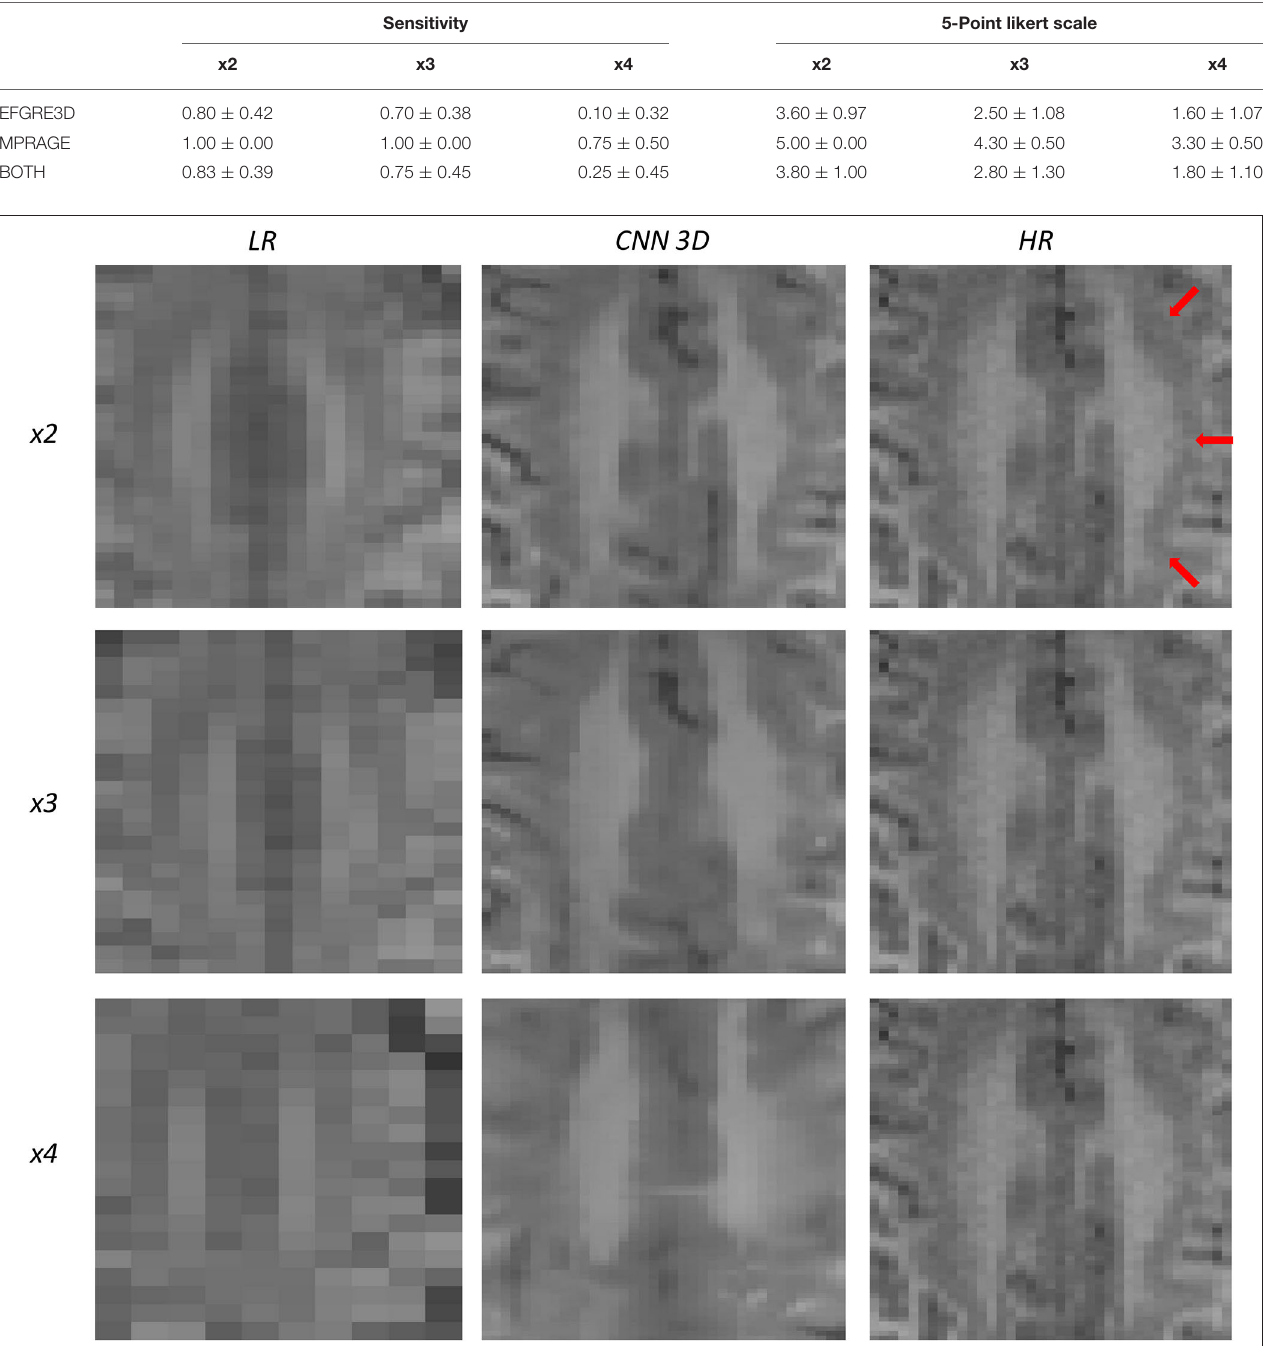
TABLE 8 | Results for two different qualitative metrics provided by the expert radiologist.